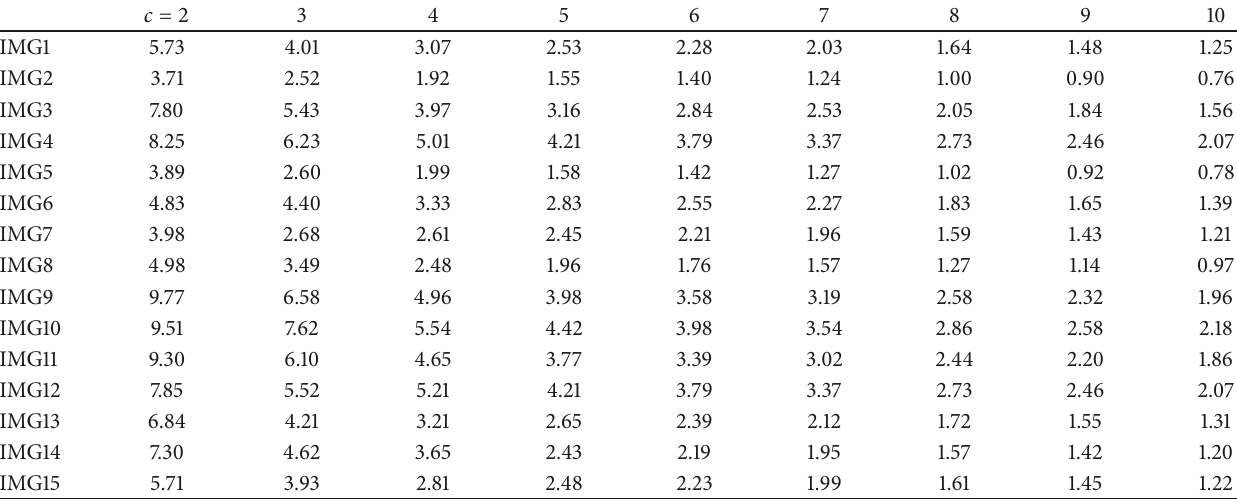
Table 10: MSE ( ×10 3 ) using FCRM with different cluster number.